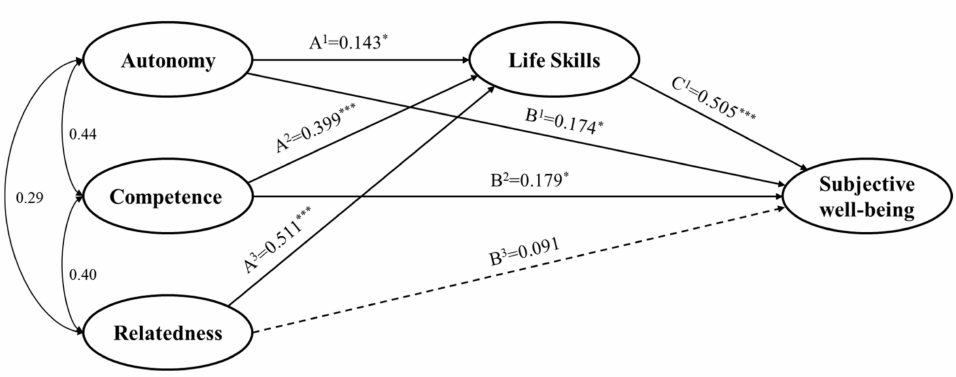
Figure 3. Standardized coefficients for hypothesized model (* p < 0.05, *** p <